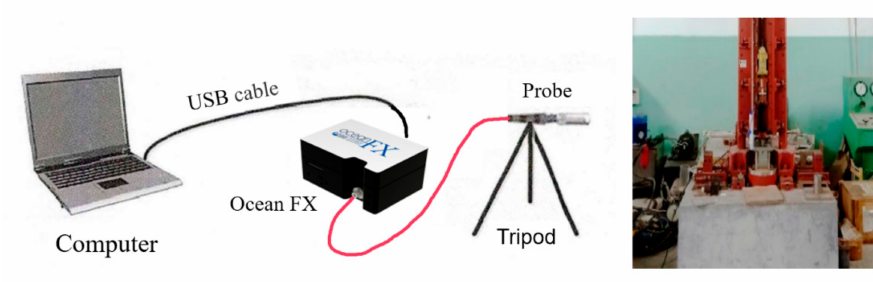
Figure 3. Schematic diagram of flame spectrum measuring